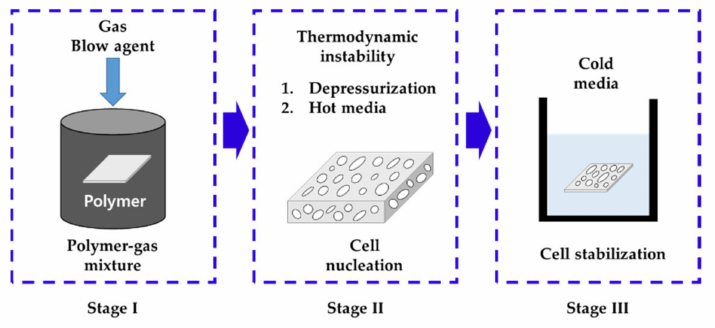
Figure 1. Theoretical principle for the solid-state batch foaming